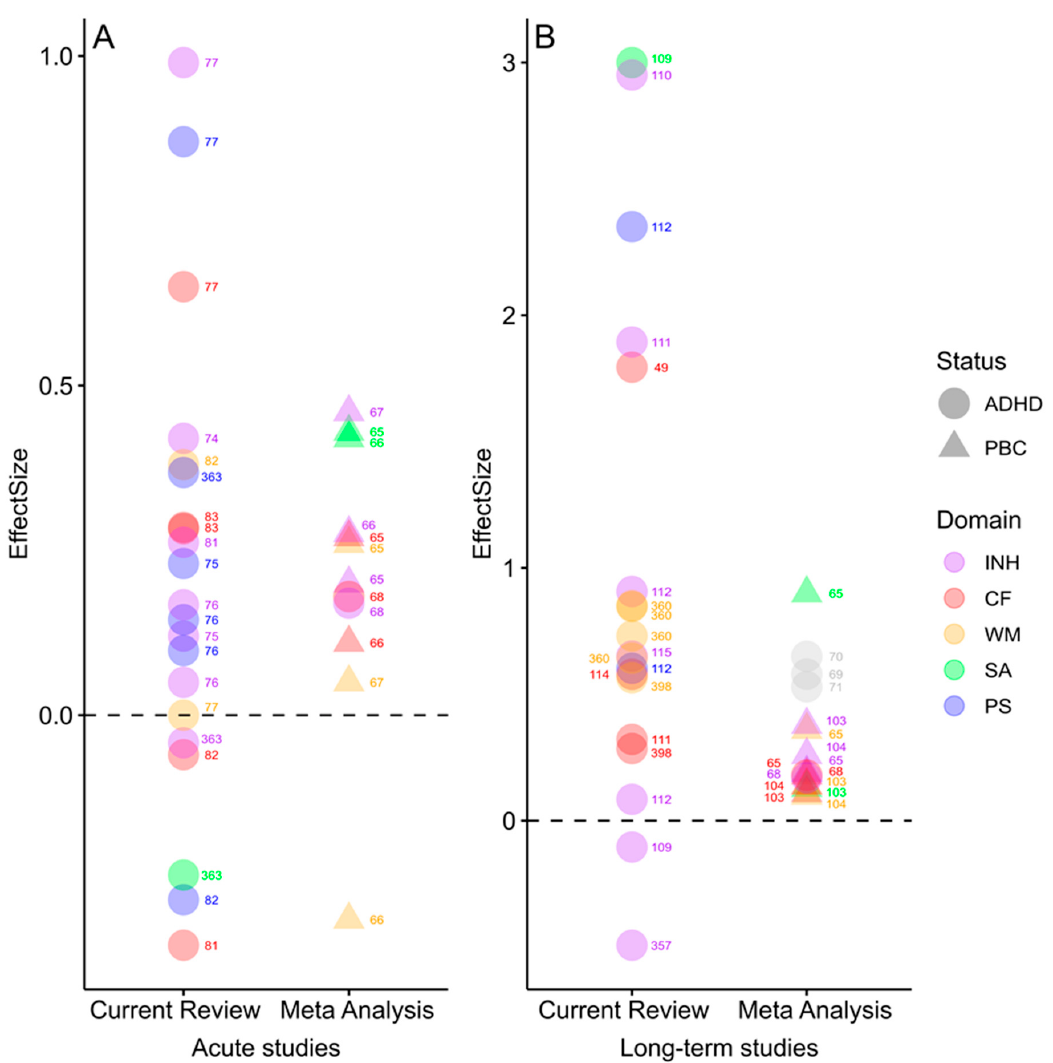
Figure 4. The e ff ects exercise on cognitive performance for children with and without ADHD. Dual-plot presenting extracted e ff ect sizes for acute ( A ) and long-term ( B ) exercise interventions color-coded by cognitive domain and plotted next to e ff ects sizes derived from published meta-analyses in children with (circles) and without (triangles) ADHD. E ff ects sizes across executive functions are depicted in grey. Please, note that scale of the ordinate di ff er between the two plots.